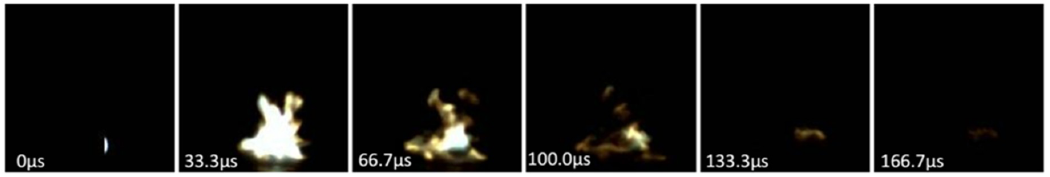
Figure 15. High‐speed photography of energetic films during laser ignition .